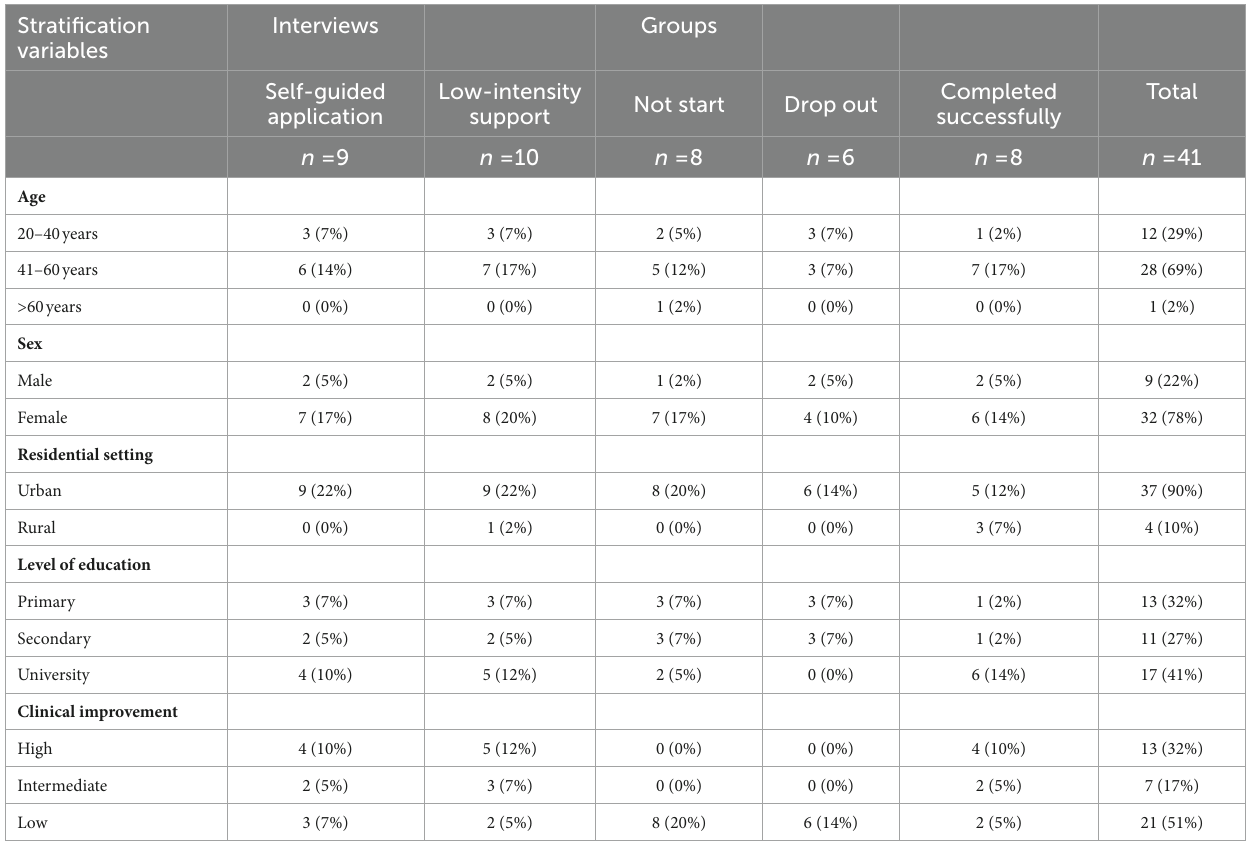
TABLE 2 Characteristics of participants ( n =